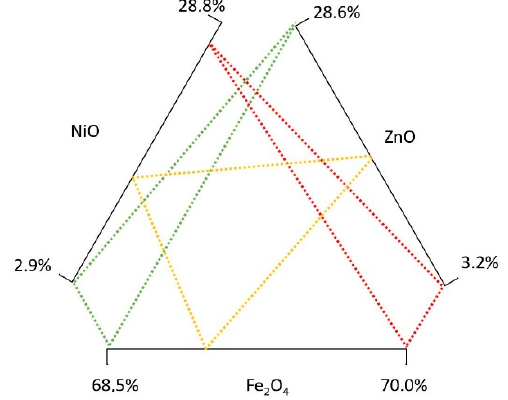
Figure 5. NiZn soft ferrite environmental impact diagram.